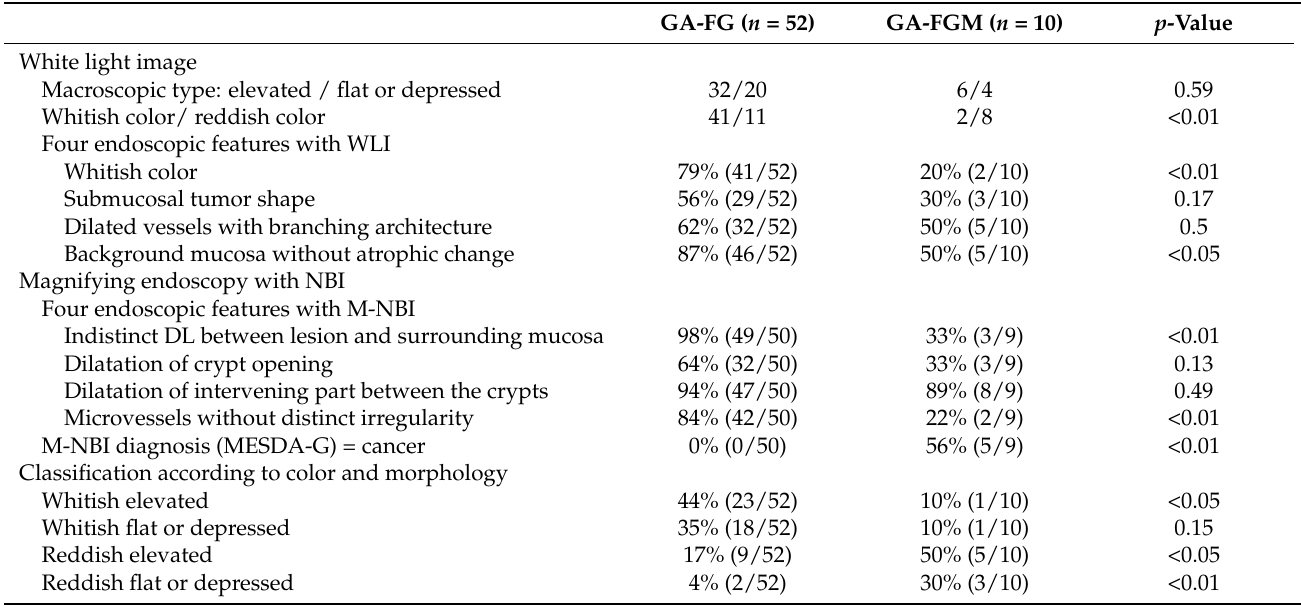
Table 1. Endoscopic features of GEN-FGML.